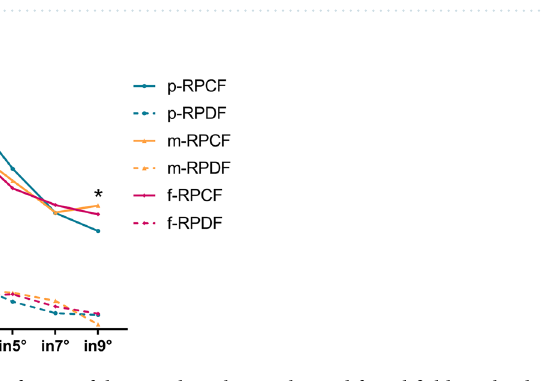
Figure 5. Recovery points of vergence fusion of the peripherial, macular and foveal fields at the different torsional angles.